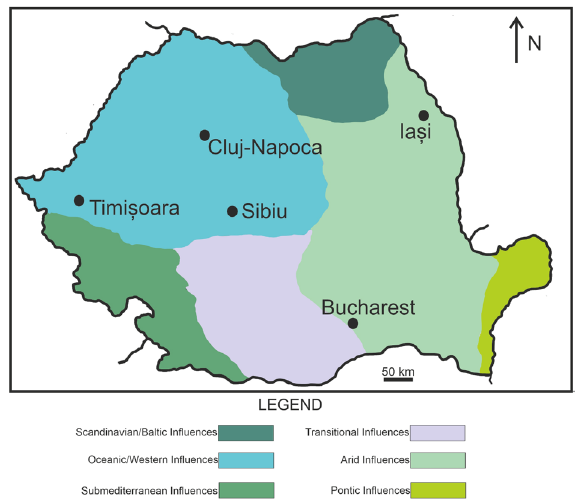
Figure 7. The cities involved in the analysis and the climatic influences in Romania. The map was made in the CorelDraw 2020 software (www. corel draw.